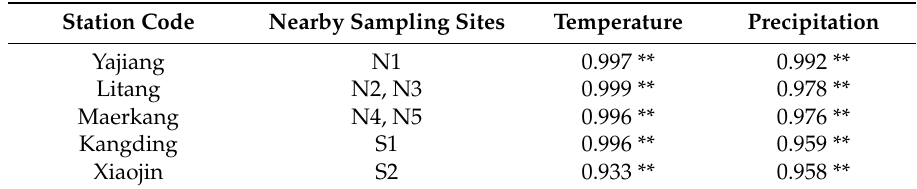
Table A2. Correlation between climate data from the gridded database (CRU) and regional meteorological station during the period of